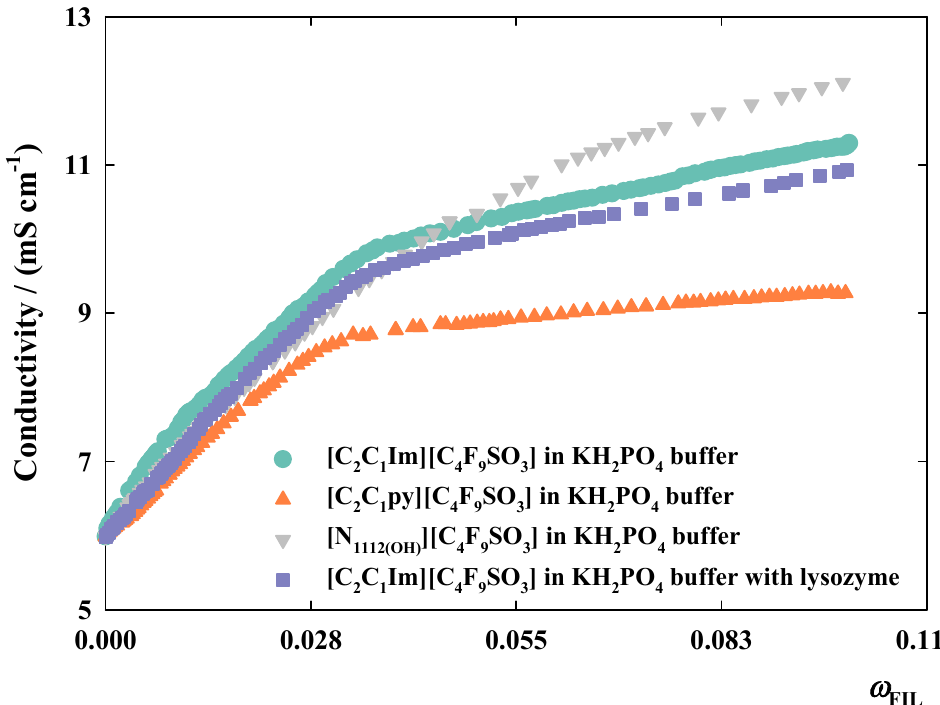
Figure 1. Conductivity profiles of [C 2 C 1 Im][C 4 F 9 SO 3 ]— buffer with lysozyme (0.2 mg/mL).